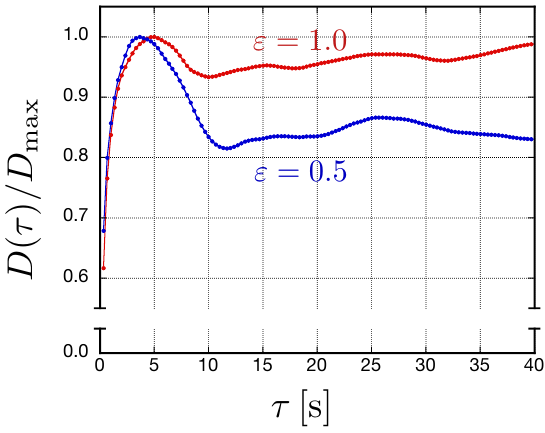
Figure 3. D ( τ ) obtained from the data shown in Figure 2. Blue and red lines distinguish D ( tau ) for varepsilon = 0.5 and 1.0, respectively. The vertical axis is normalized using the values D max at the peak of the curves. D max = 3.3 µ m 2 /s for ε = 0.5, and 18.8 µ m 2 /s for ε = 1.0.